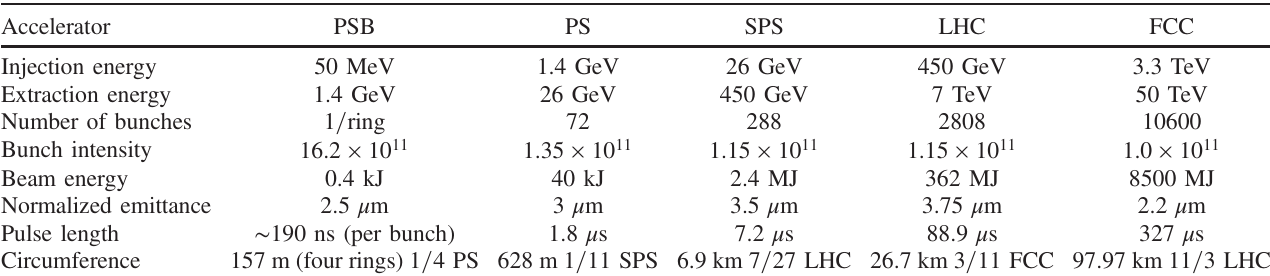
TABLE II. Typical parameters of the CERN hadron accelerator complex. Accelerator PSB Injection